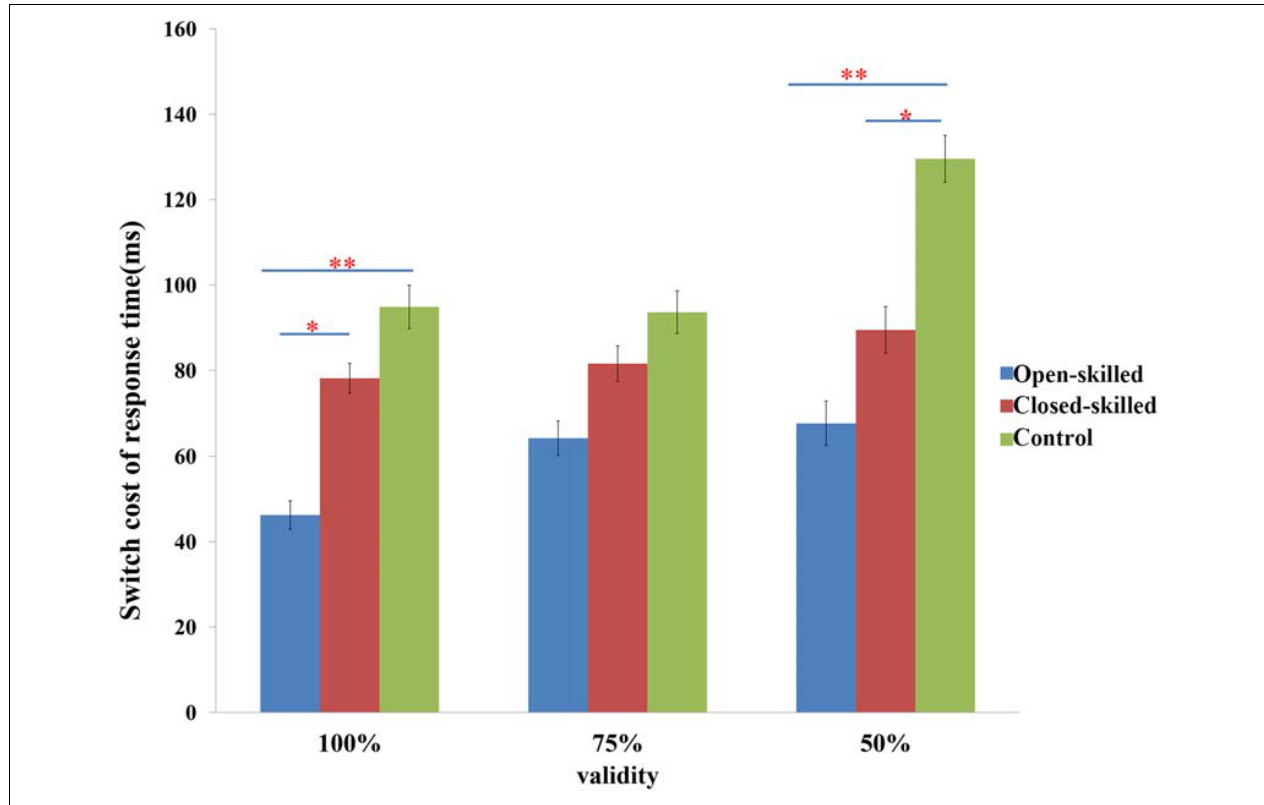
FIGURE 2 | The switch cost of response times in task-switching paradigm. Switch cost of response time = response time of switch trials – response time of repeat trials; 100% denotes 100% valid cue; 75% denotes 75% valid cue; 50% denotes 50% valid cue; ∗ p < 0.050; ∗∗ p <